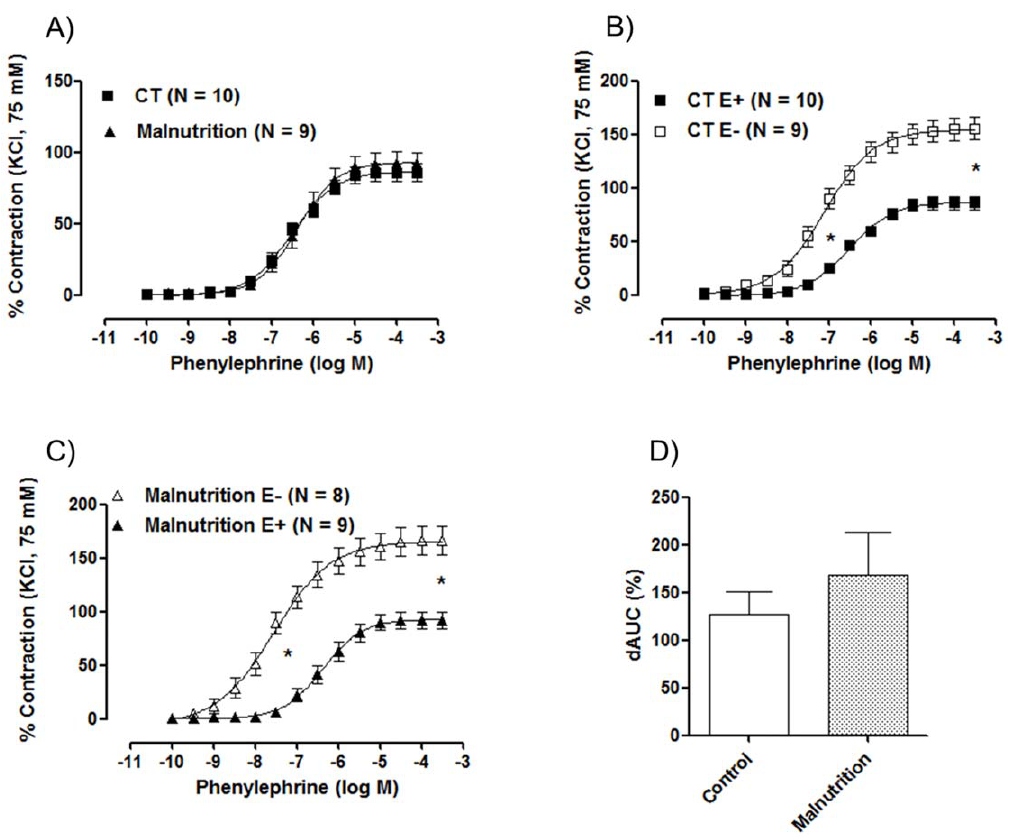
Figure 1. The effects of post-weaning protein malnutrition on the concentration-response curves of phenylephrine. (A) Concentration-response curve to phenylephrine in isolated aortic rings from control (CT) and post-weaning protein malnutrition (Malnutrition) groups. (B, C) Concentration-response curves to phenylephrine in isolated aortic rings from control (CT) and post-weaning protein malnutrition (Malnutrition) groups before (E + ) and after removal of endothelium (E 2 ). (C) Percent difference of the area under the curve (% dAUC) in vessels with endothelium intact (E + ) and denuded (E 2 ). The number of preparations is indicated in parenthesis. The results are expressed as the means 6 SEM. * P , 0.05 for pD 2 and R max : CT E + vs. Ct E 2 ; pD 2 : Malnutrition E + vs. Malnutrition E 2 and dAUC% - CT vs. Malnutrition. Student’s t- test. doi:10.1371/journal.pone.0034876.g001 PLoS ONE |